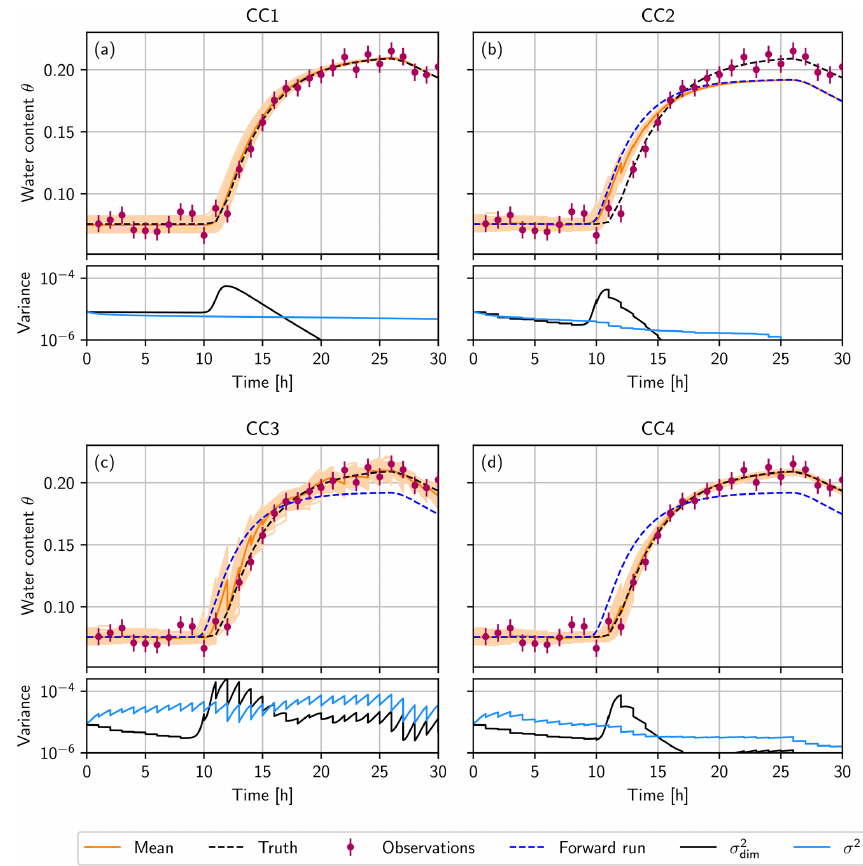
Figure 3. (a) Convergent case 1 (CC1) is the forward run without data assimilation, using an interpolated initial condition. In the other three cases, the truth is used to generate the initial ensemble. (b) Convergent case 2 (CC2), where the ensemble is propagated with n = 2 . 68 instead of n true = 2 . 28, and the state is estimated. (c) Convergent case 3 (CC3), where the parameter error is represented by the ensemble, using N ( 2 . 68 , 0 . 4 2 ) , and the state is estimated. (d) Convergent case 4 (CC4) with the simultaneous state and parameter estimation. In the upper plots (a–d) , the ensemble mean (orange) and the ensemble (light orange lines) during the forward run at the depth of the uppermost observation (20cm). The truth, which is used to generate the observations (purple), is shown as a black dashed line. Panels (b–d) additionally show a single forward run (blue dashed line), using a wrong parameter n = 2 . 68, starting from the true initial condition. In the lower plots (a–d) , the mean variance σ 2 of the ensemble over all dimensions (light blue line) and variance σ 2 at the depth of 20cm (black dim